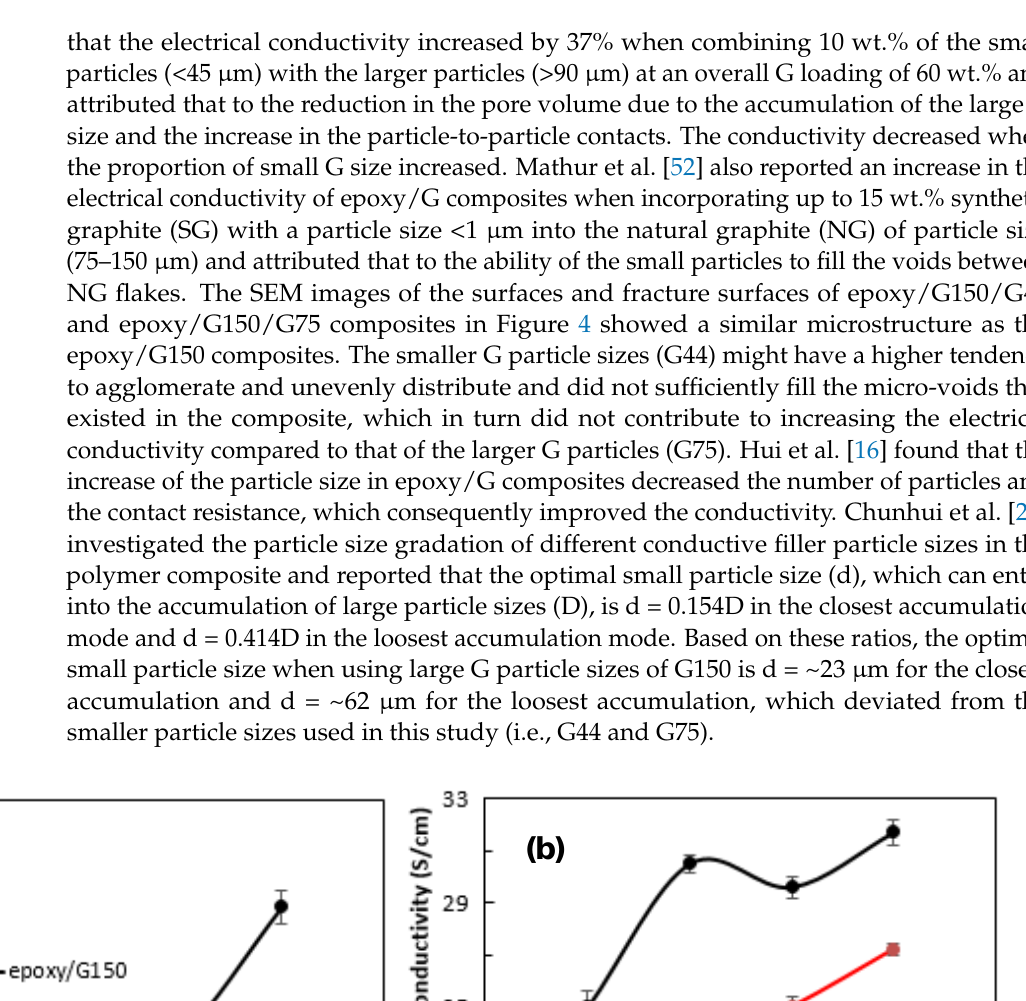
Surface (65 wt.%) Surface (80 wt.%)